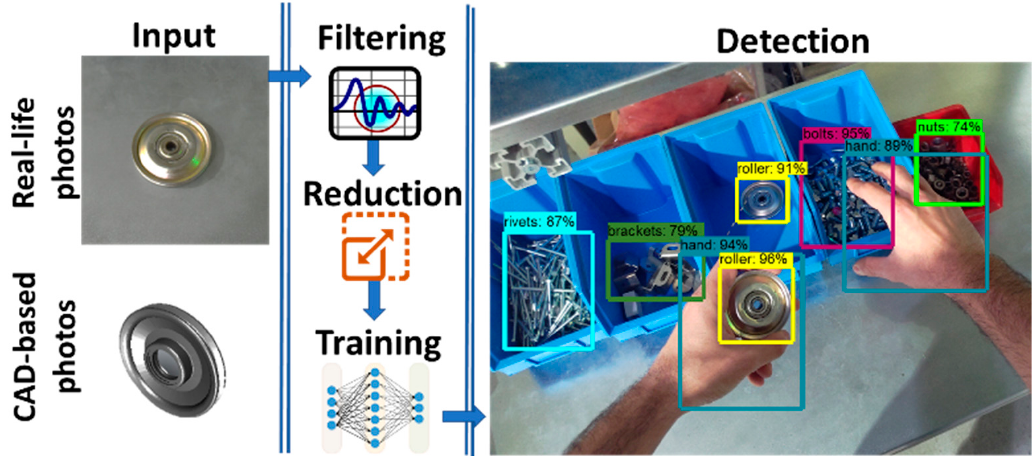
Figure 3. APM—detection of parts position/parts being manipulated.